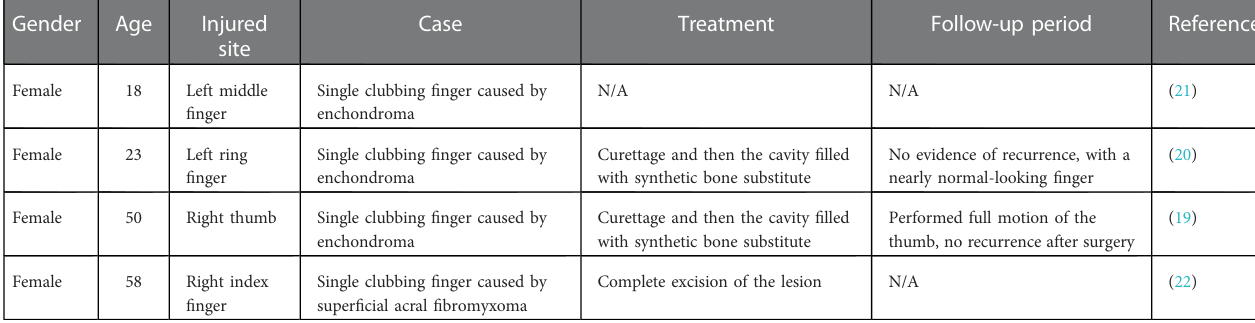
TABLE 1 Cases with single clubbing fi